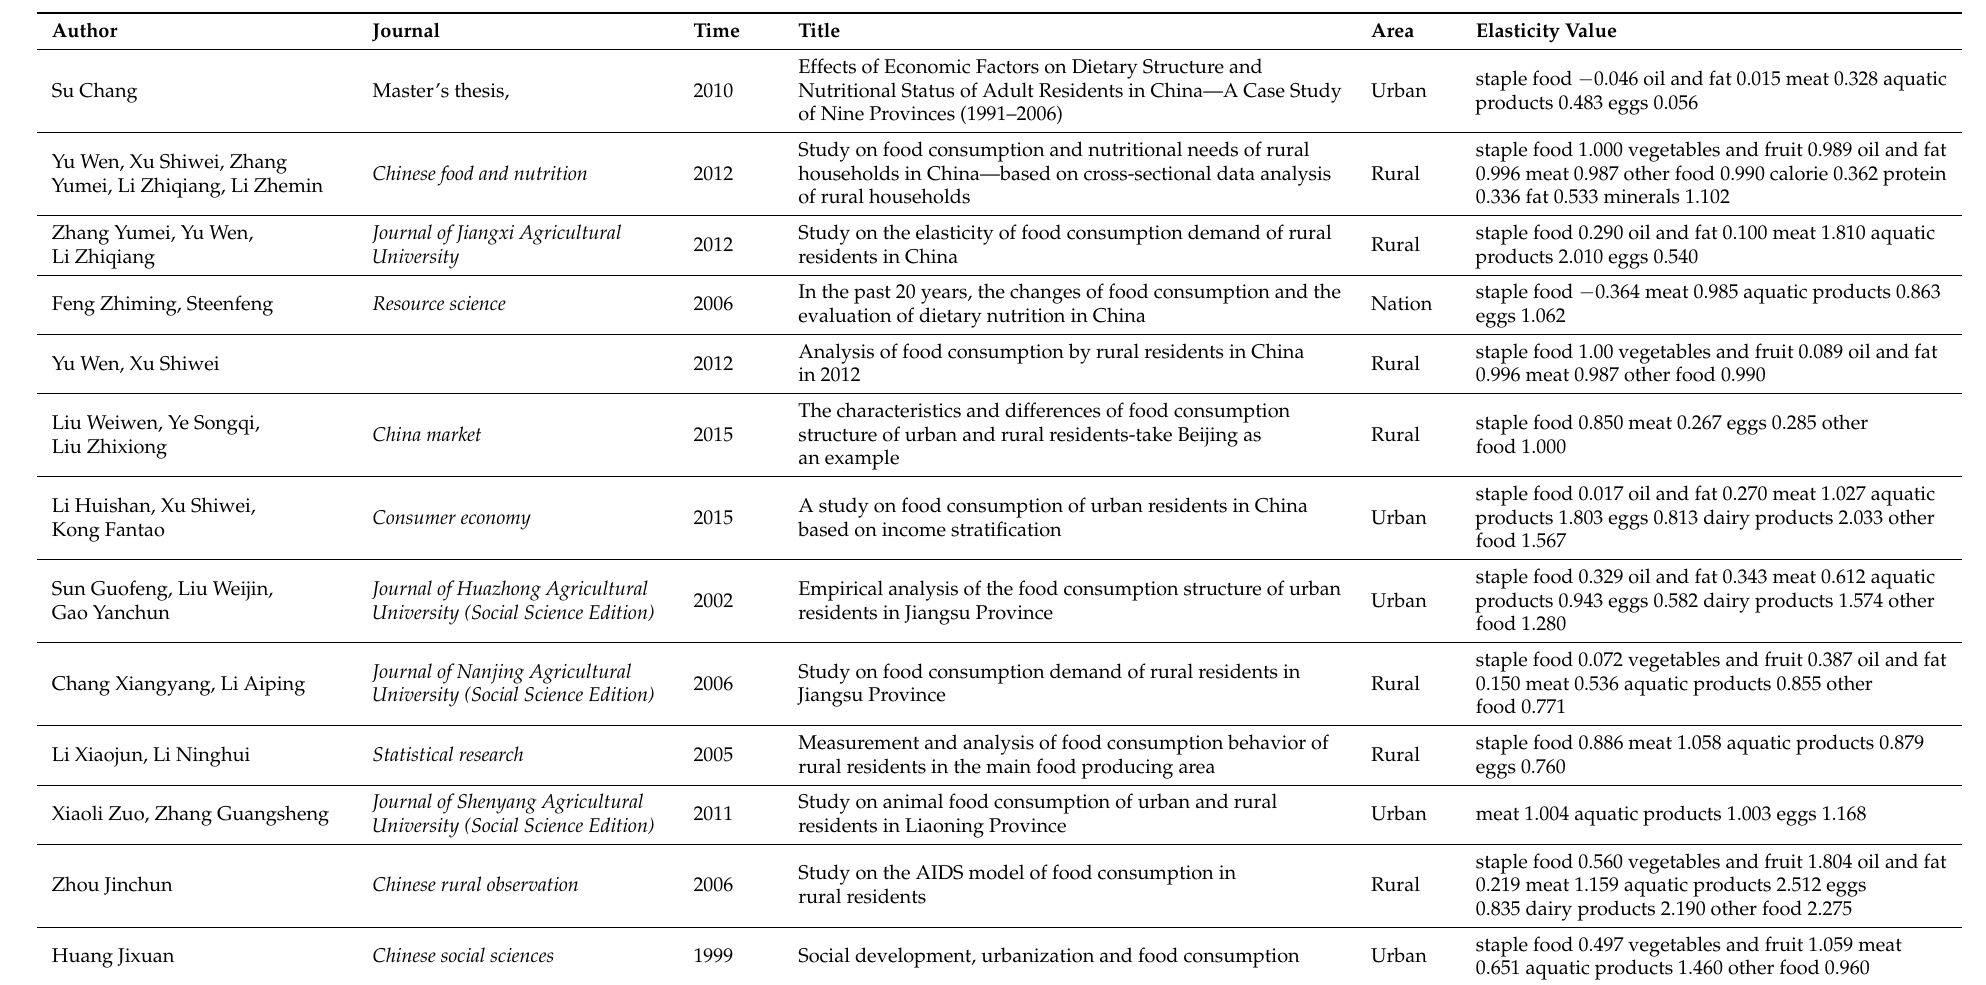
Table A1. List of Primary